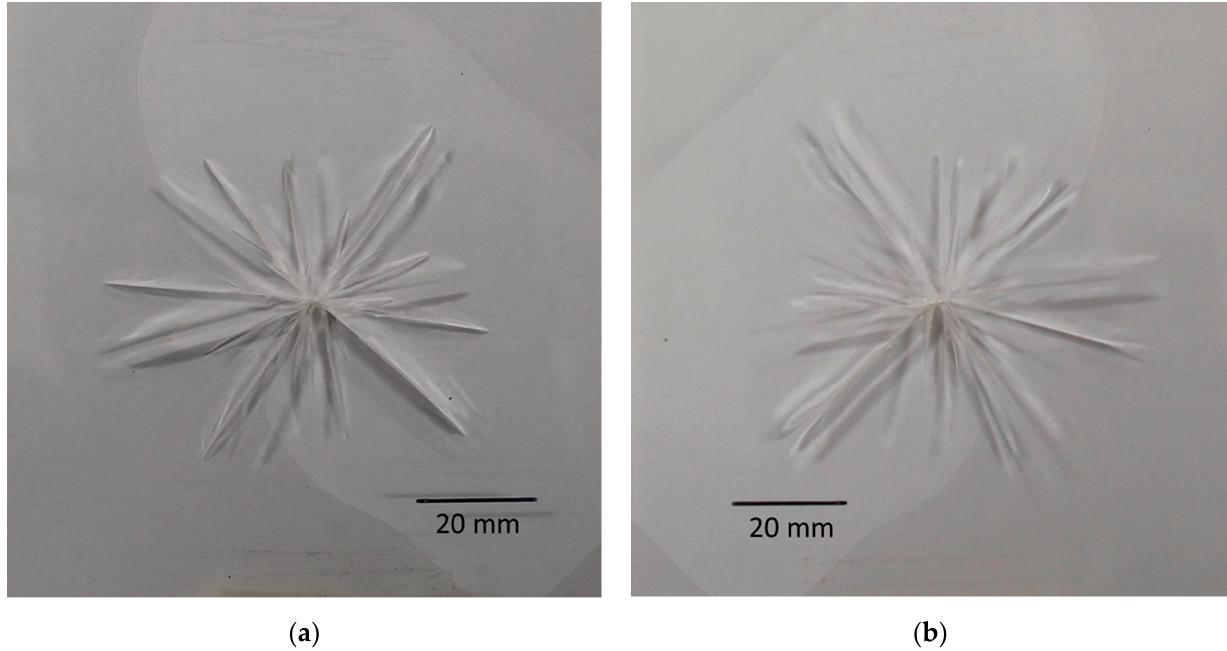
Figure 9. PMMA Specimen without adhesion at 12 J impact energy, ( a ) top layer and ( b ) bottom layer.